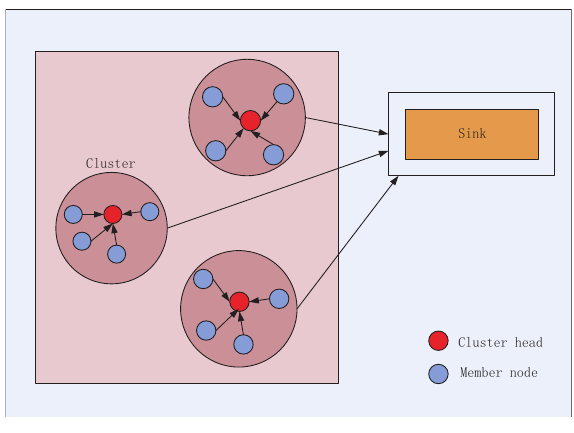
Figure 1. Network